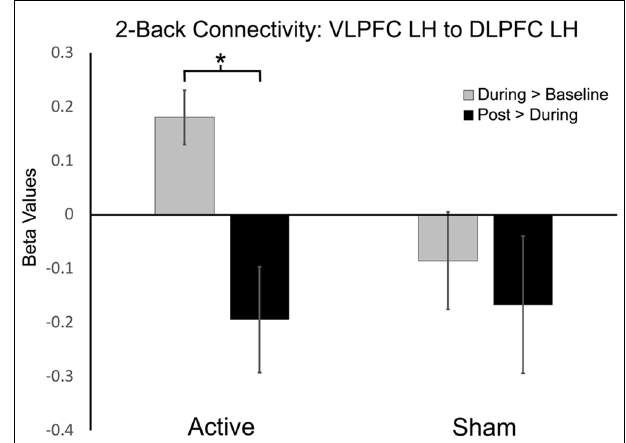
FIGURE 3 | Functional connectivity beta values in active vs. sham session contrasts (seeding left ventrolateral prefrontal cortex, VLPFC to target left dorsolateral PFC, DLPFC). ∗ P-FDR <